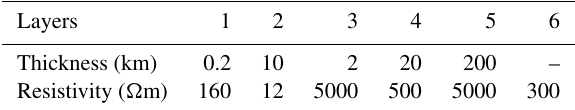
Table 2. Multiple horizontal layers model.